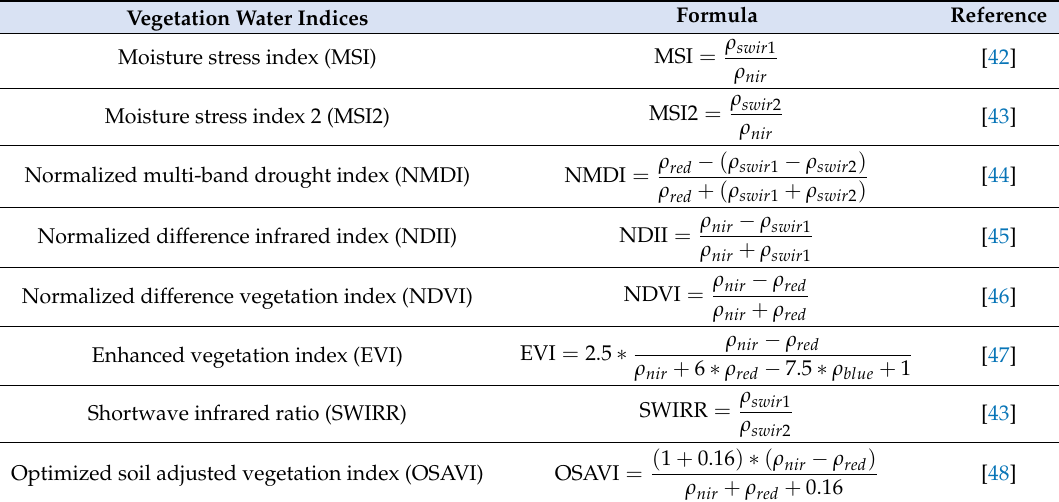
Table 2. Formulas used to calculate the 8 vegetation water indices in this